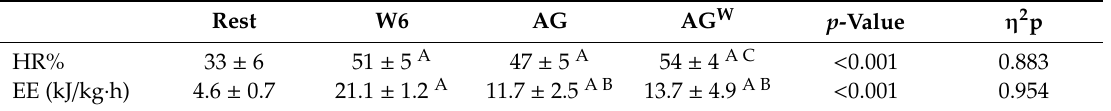
Table 1. Group average for relative heart rate (%HR) and relative energy expenditure (EE) during rest, active gaming (AG), active gaming with added weights (AG W ), and walk (W6). Rest W6 AG AG W Rest W6 AG AG W